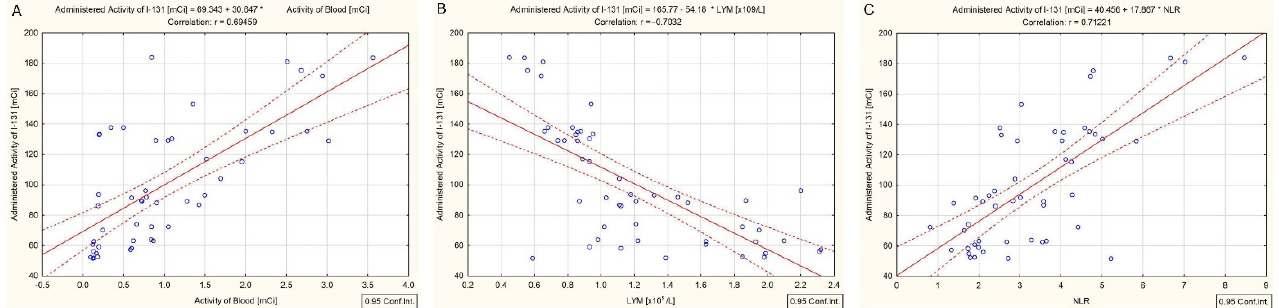
Figure 5. Correlation measured at 69 h post-administration between the 131 I activity and whole blood activity ( A ), absolute lymphocytes count ( B ) and NLR ( C ).